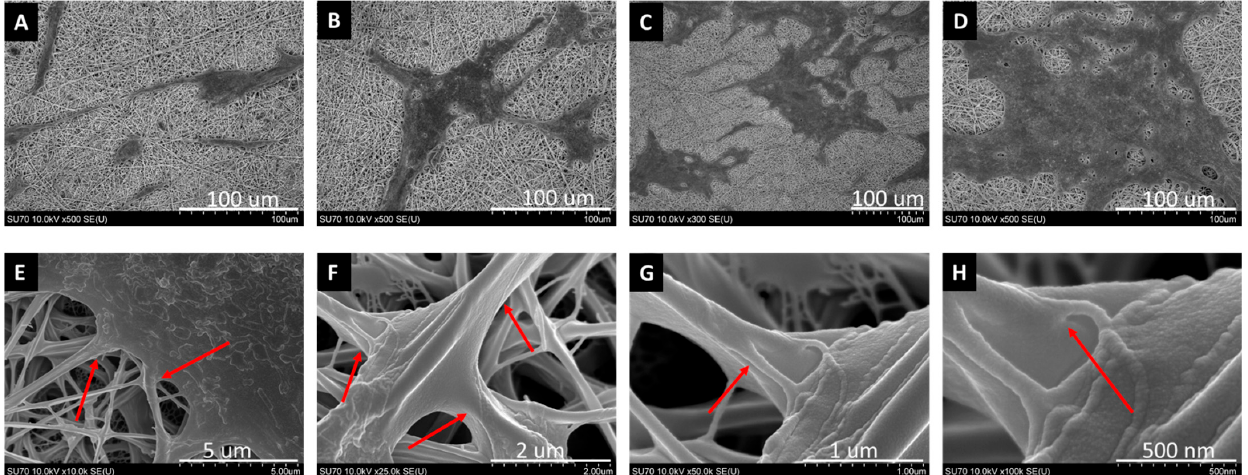
Figure 5. SEM images of RPE cells on the IBP-coated PCL nanofibrous membranes. ( A – D ) RPE cells growth on membranes on Days 1, 3, 7, and 14. The RPE cells formed a striking in vivo-like regional monolayer on Day 14 ( D ). With the help of integrin-binding peptides, the RPE cells formed a very tight connection with nanofibers ( E – H ), and the red arrows indicated the tight junctions.